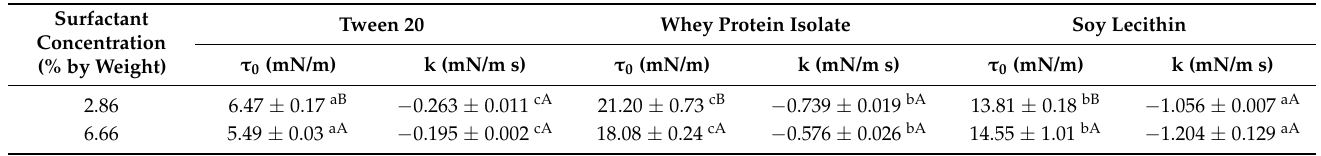
Table 1. Fitting parameters of the dynamic interfacial tension curves. 1